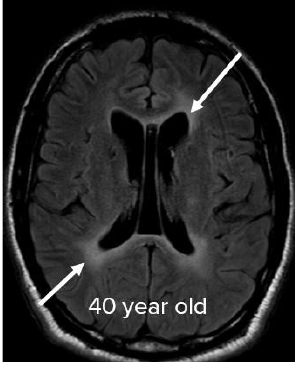
Figure 7. Periventricular involvement. Axial FLAIR image depicts periventricular FLAIR hyperintensities in a 40-year-old patient, otherwise not explained by chronic microangiopathic changes and absence of other risk factors. Image has been windowed manually to improve the visibility of signal abnormality.